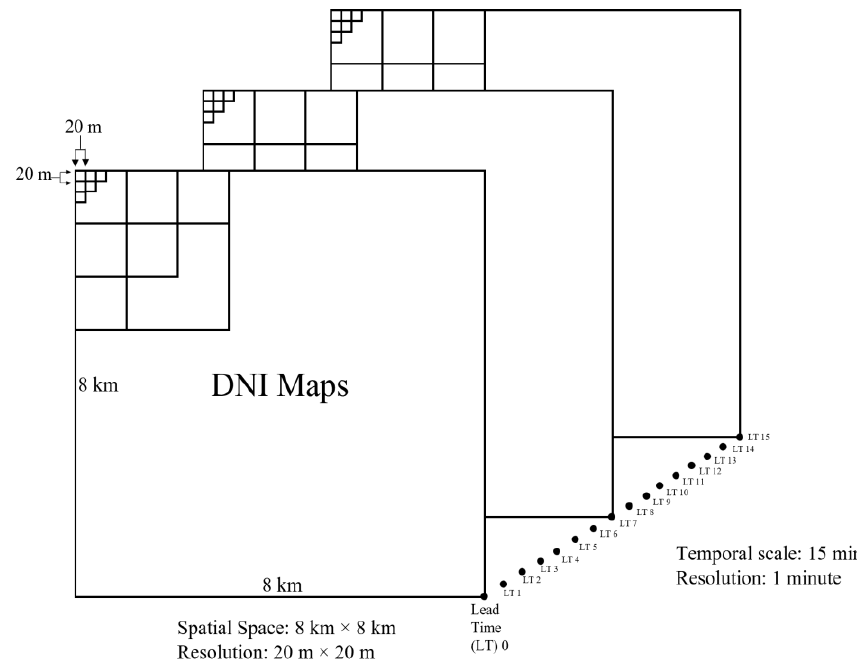
Figure 6. Description of the nowcast maps (DNI maps).